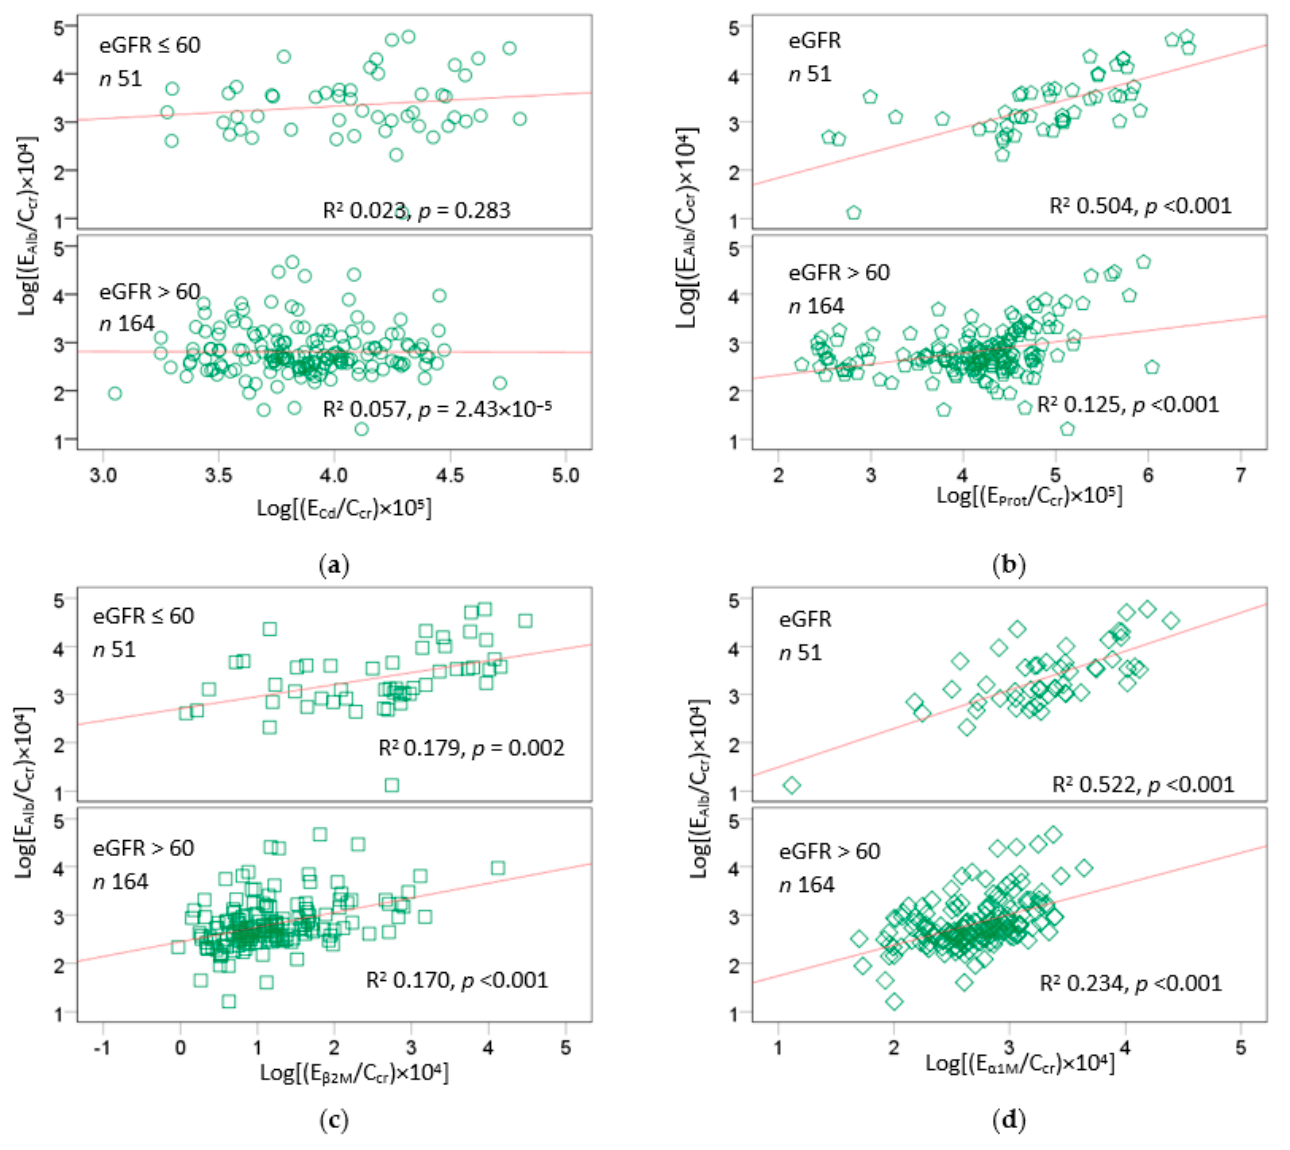
Figure 2. Effects of cadmium exposure and nephron mass on excretion of albumin. Scatterplot ( a ) relates log[(E Alb /C cr ) × 10 4 ] to log[(E Cd /C cr ) × 10 5 ]. Scatterplot ( b ) relates log[(E Alb /C cr ) × 10 4 ] to log[(E Prot /C cr ) × 10 5 ]. Scatterplot ( c ) relates log[(E Alb /C cr ) × 10 4 ] to log[(E β 2M /C cr ) × 10 4 ]. Scatterplot ( d ) relates log[(E Alb /C cr ) × 10 4 ] to log[(E α 1M /C cr ) × 10 4 ]. Units of E Alb /C cr , E β 2M /C cr , and E α 1M /C cr are mg/L of filtrate, and the unit of E Cd /C cr is μ g/L of filtrate. Coefficients of determination (R 2 ) and p -values are provided for all scatterplots.